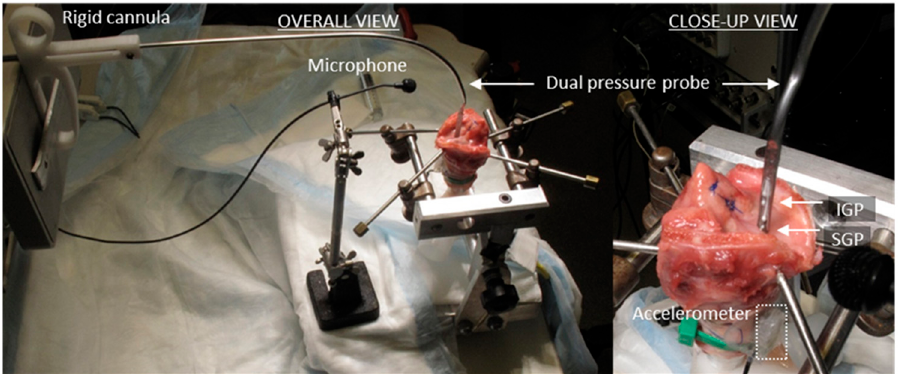
Figure 2. Whole-mount cadaver excised larynx preparation with ISP probe sensors measuring intraglottal pressure (IGP) and subglottal pressure (SGP) signals. An acoustic microphone was placed 15 cm from the glottis, and an accelerometer recorded the vibrations of the anterior, external tracheal wall of the specimen.